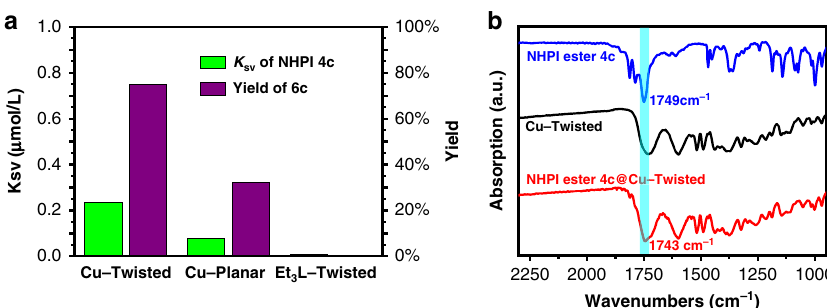
Fig. 5 Coordination activations of Cu(II) sites in Cu(II) – TPA. a Comparison of fl uorescence quenching (upon addition of NHPI ester 4c ) and catalytic ef fi ciencies of Cu – Twisted , Cu – Planar , and ester form of ligand. b Comparative IR studies on coordination activations of framework. The ester stretching vibrations of free and adsorbed 4c were highlighted by the inserted turquoise bands.